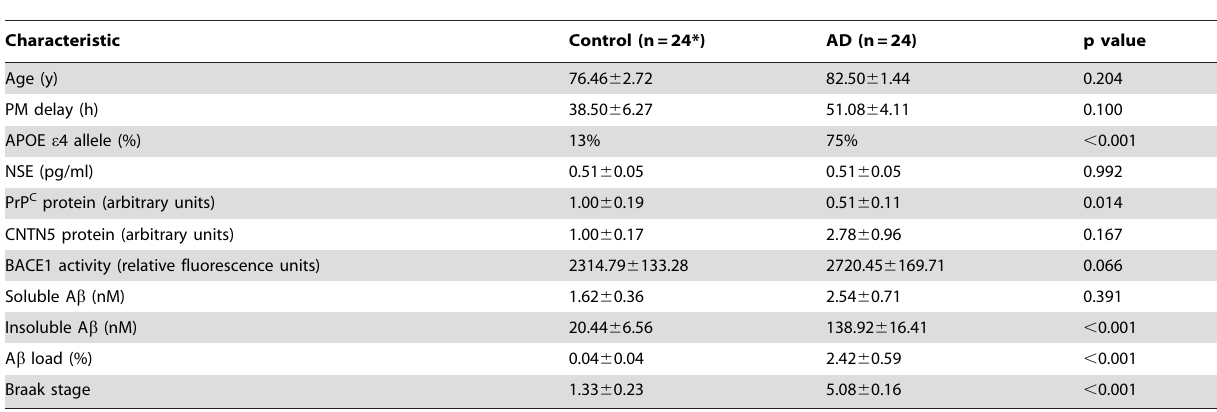
Table 1. Summary data of the sporadic AD and age-matched control samples.